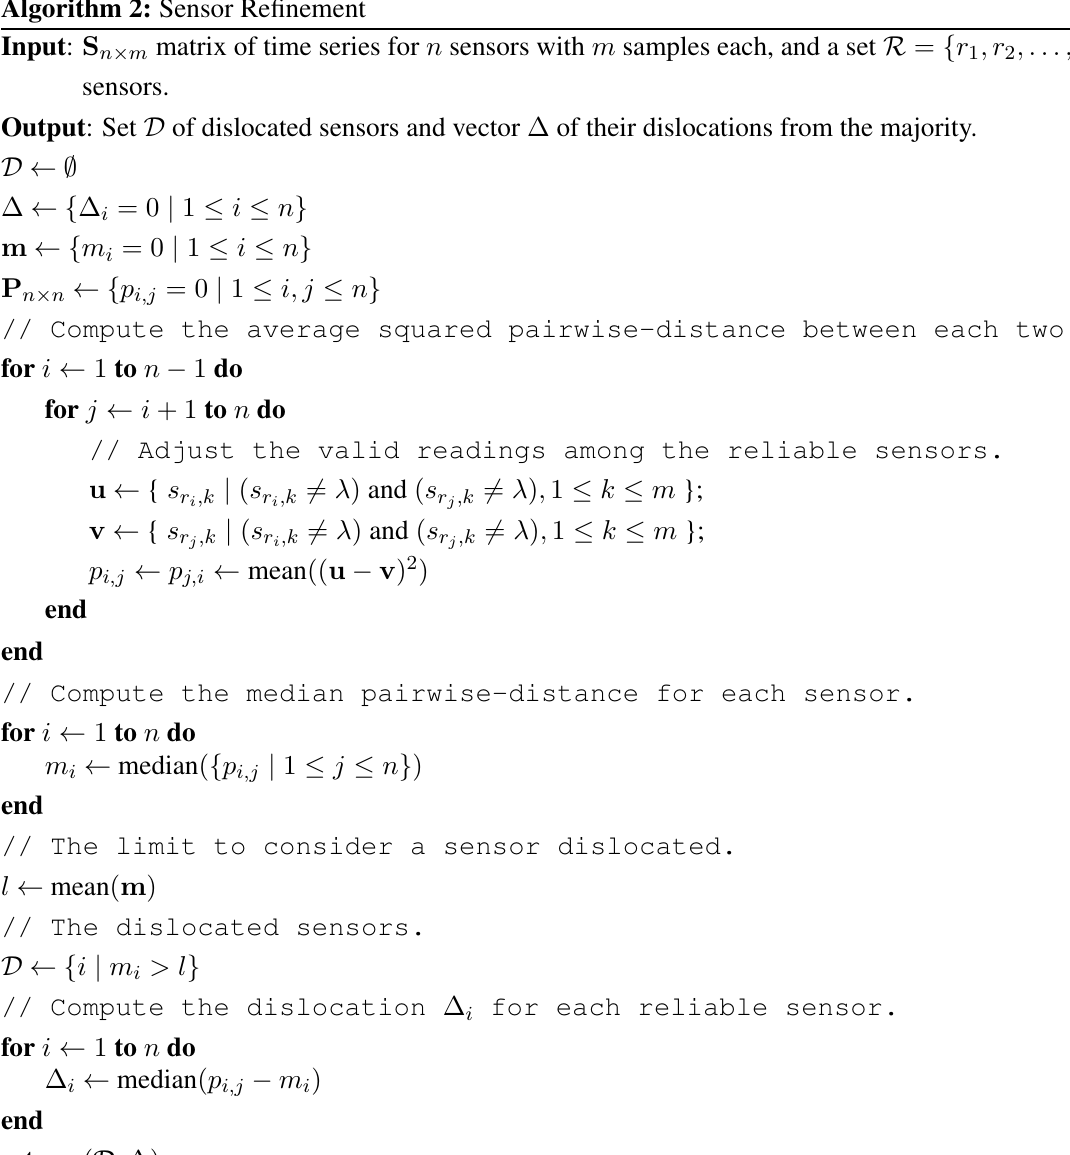
Algorithm 2: Sensor